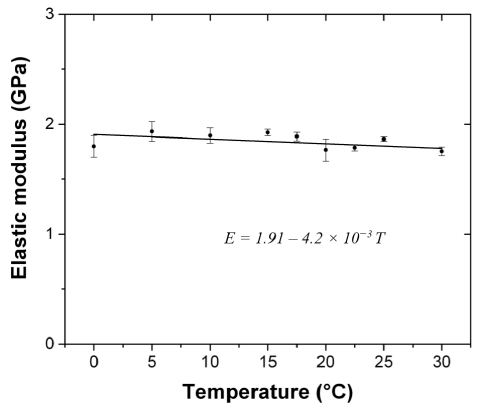
Figure 7. Evolution of the instantaneous elastic modulus with the temperature, calculated from the measurement of ultrasonic pulse